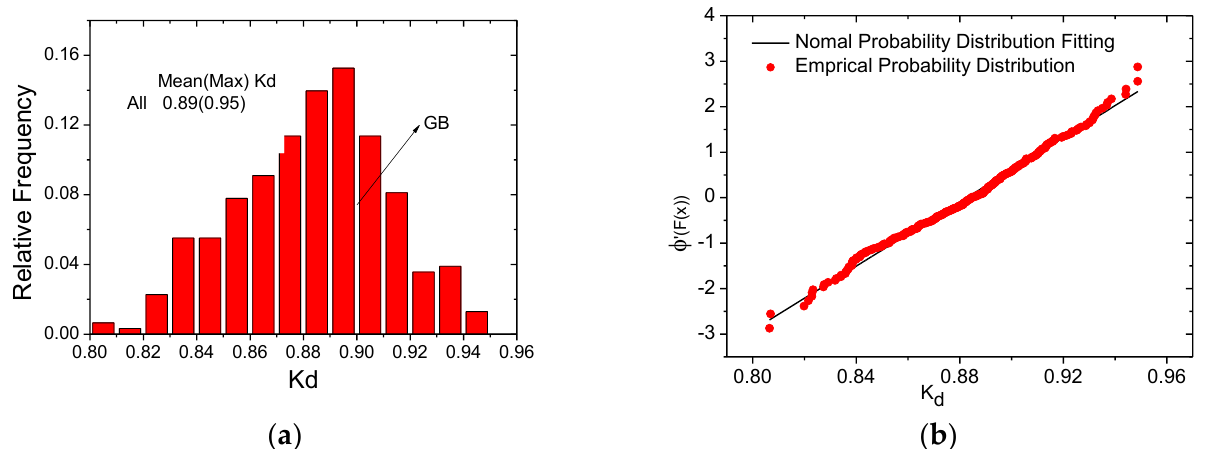
Figure 18. Histogram and probability distribution fitting results of K d for unknown building orientations. ( a ) Wind directionality factors K d , ( b ) Probability distribution fitting result for K d .